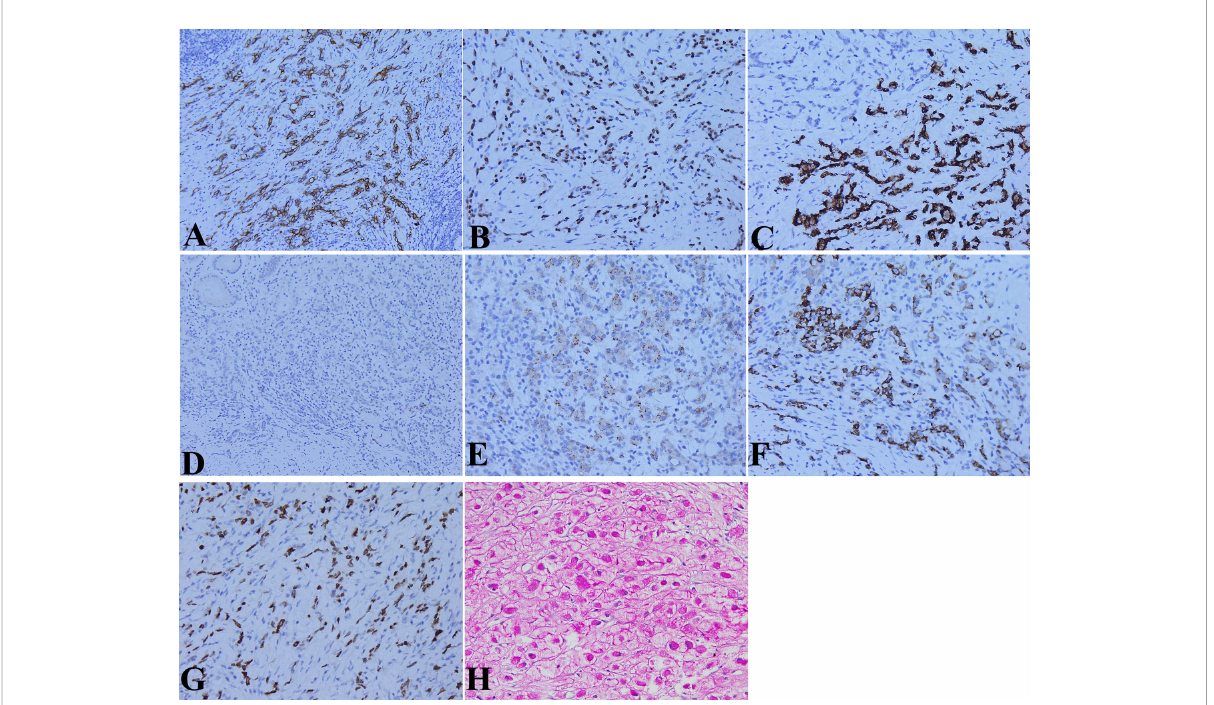
FIGURE 4 Molecular pathological features of HAS by immunohistochemical (IHC) staining and special staining. (A) Cytokeratin (CK) expression in the cytoplasm of two kinds of tumor cells (IHC staining, ×200 magni fi cation). (B) Caudal-related homeobox transcription factor 2 (CDX2) expression in the nucleus of the two kinds of tumor cells (IHC staining, ×200 magni fi cation). (C) Mucin 2 expression in the cytoplasm of the two kinds of tumor cells (IHC staining, ×400 magni fi cation). (D) No alpha fetoprotein (AFP) expression in the cytoplasm of the two kinds of tumor cells (IHC staining, ×400 magni fi cation). (E) Glypican-3 expression in the cytoplasm of hepatoid carcinoma cells (IHC staining, ×400 magni fi cation). (F) Hepatocyte expression in the cytoplasm of hepatoid carcinoma cells (IHC staining, ×400 magni fi cation). (G) Spalt-like transcription factor 4 (SALL4) expression in the nucleus of hepatoid carcinoma cells (IHC staining, ×400 magni fi cation). (H) Red periodic acid-Schiff (PAS) staining in the cytoplasms of signet ring cells (IHC staining, ×400 magni fi